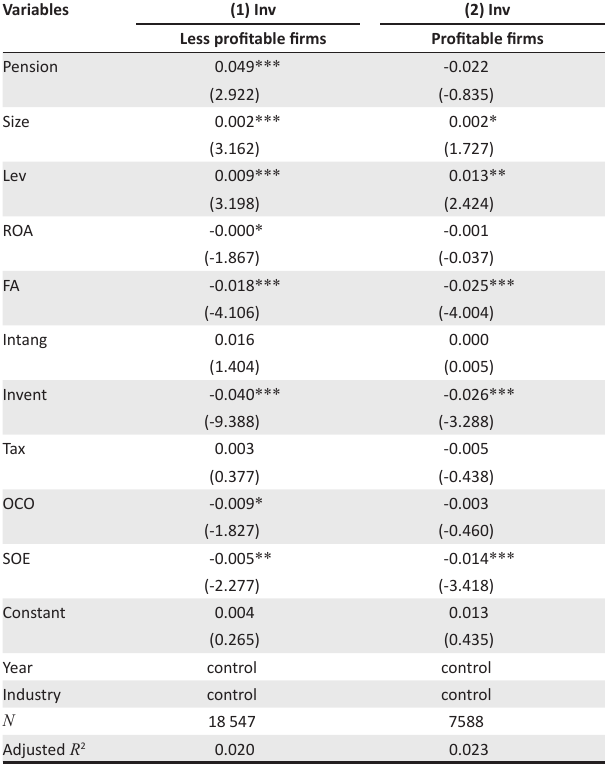
TABLE 11: Profitability-adjusted test.